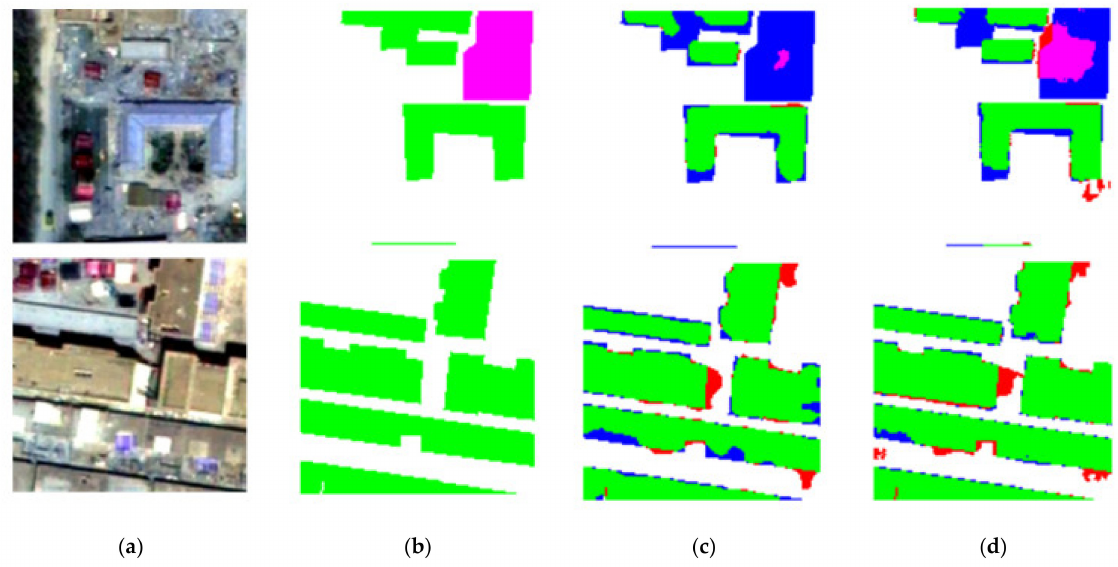
Figure 1. Examples of the detection results of earthquake-damaged buildings by using different networks, ( a ) original images; ( b ) ground truth map; ( c ) predicted results by DeepLabv3+; ( d ) predicted results by UNet; green, purple, white, blue and red in ( b – d ) separately represent non-collapsed buildings, collapsed buildings, others, false negative and false